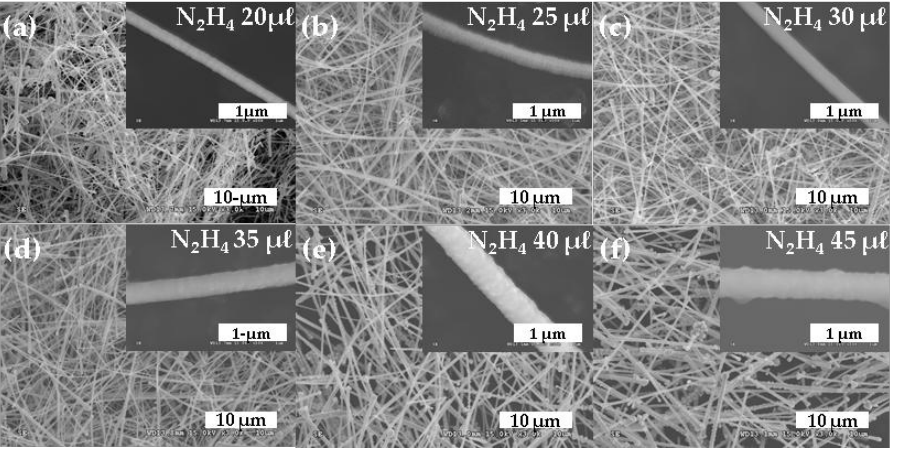
Figure 2. SEM images of Cu-NW for N 2 H 4 concentrations of ( a ) 20, ( b ) 25, ( c ) 30, ( d ) 35, ( e ) 40, and ( f ) 45 μL.